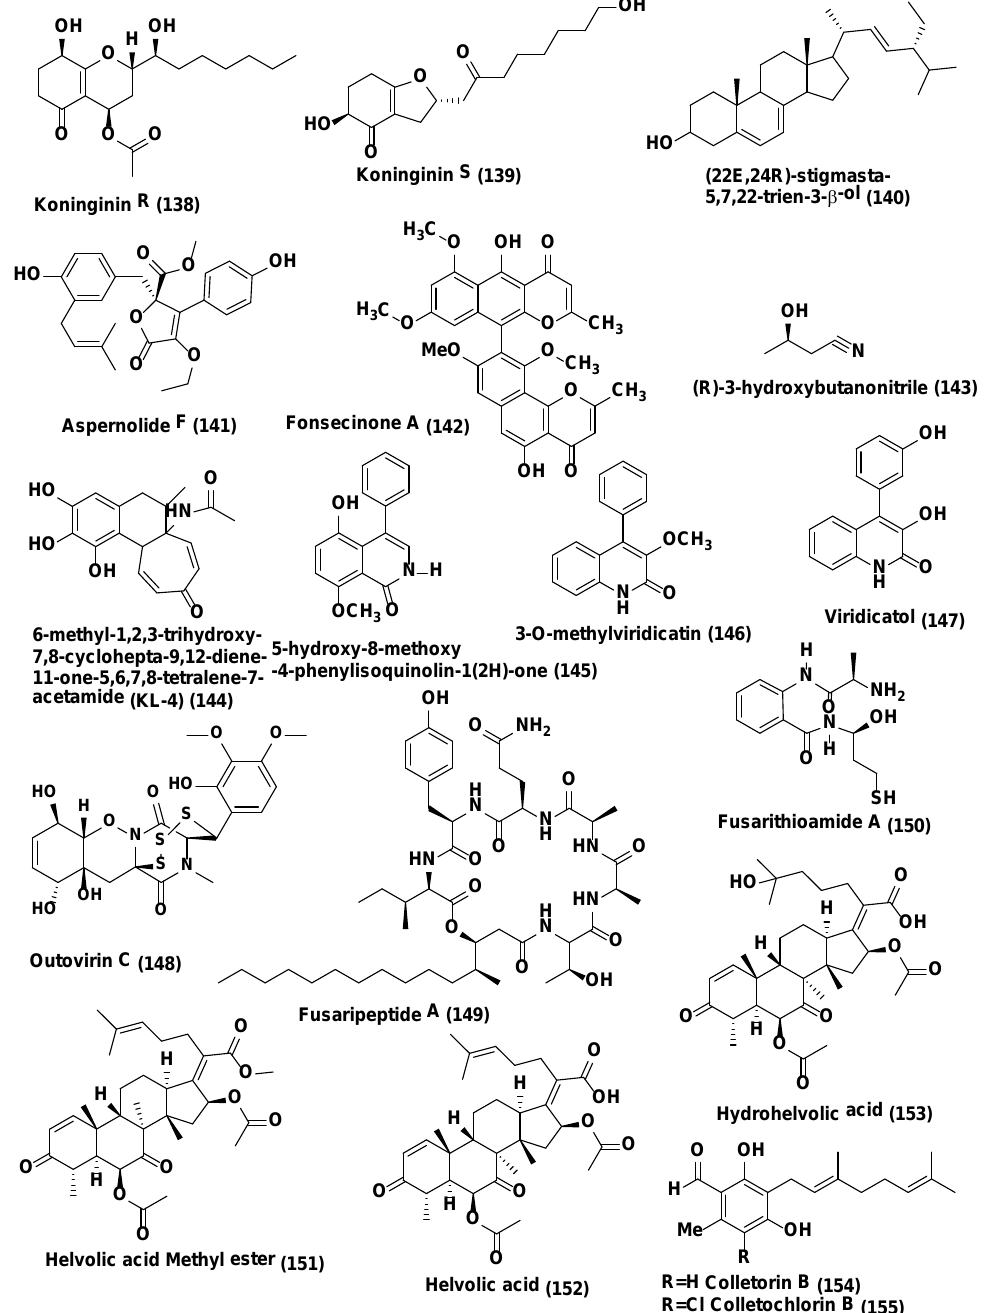
Figure 7. Structures of metabolites isolated from Hyphomycetes ( 138 – 155 ).